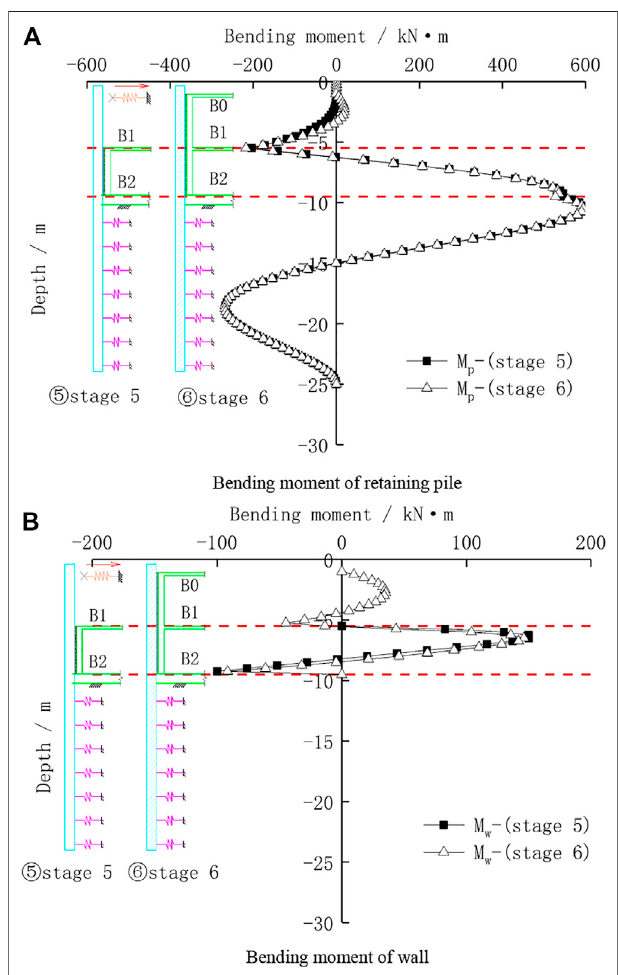
FIGURE 9 | Bending moment of the pile wall combination structure under different stages. (A) Bending moment of the retaining pile. (B) Bending moment of the